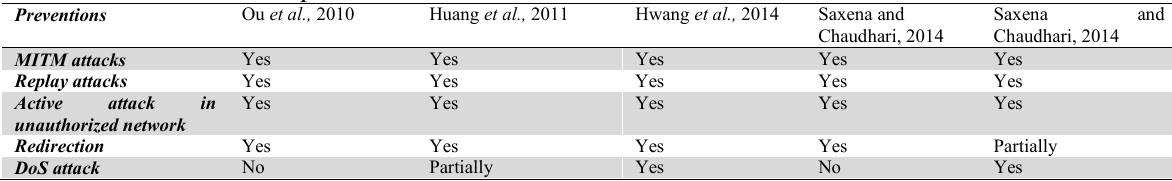
FBS based MITM attacks